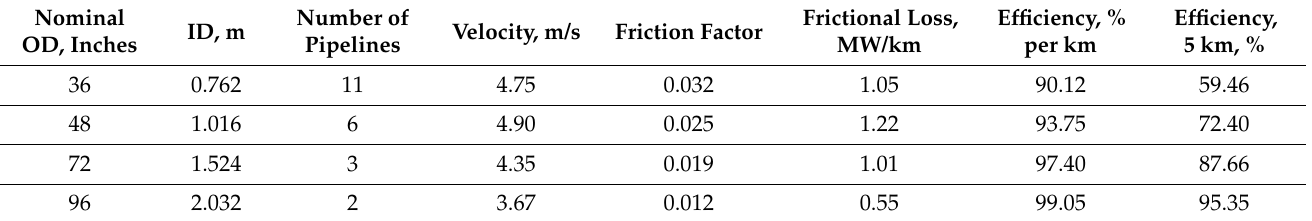
Table 2. Dimensions and other characteristics of parallel pipelines that would carry the water for the operation of a 100 MW unit with H = 500